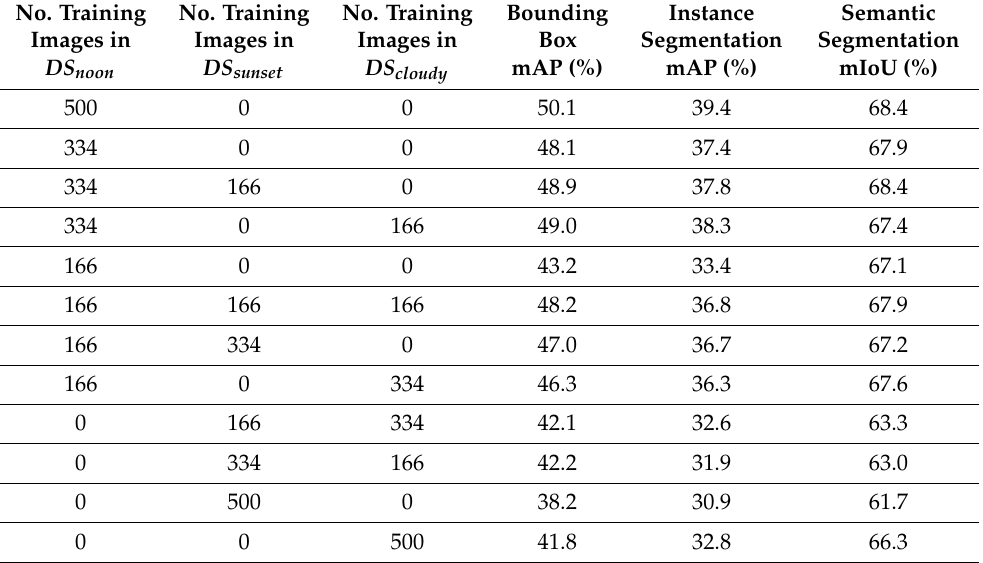
Table 6. Influence of light inconsistency on the performance of CNN